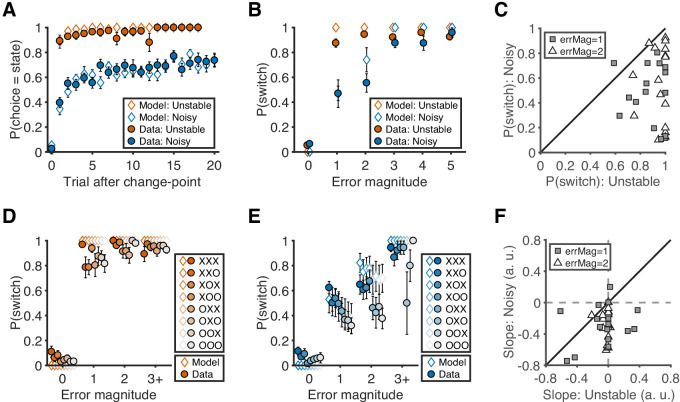
Behavioral results.(A) Probability of choosing the best target after change-points. Symbols and error bars are mean ± SEM across subjects (solid symbols) or simulations (open symbols). (B) Relationship between error magnitude and switch probability. Symbols and error bars are as in A. (C) The distribution of switch probabilities for small errors (magnitude of 1 or 2) in both conditions. Each data point represents one participant. Distributions for all error magnitudes are shown in Figure 2—figure supplement 1. (D) Probability of switch as a function of current error magnitude and error history in the unstable condition. Different colors represent different error histories for the past three trials. A correct trial is marked as O, and an error trial is marked as X. For example, XOO implies that trial t-1 was an error trial, and trial t-2 and trial t-3 were correct trials. Symbols and error bars are mean ± SEM across subjects. (E) Probability of switch as a function of current error magnitude and error history in the noisy condition. Symbols and error bars are as in D. (F) The distribution of the slopes of switch probability against error history for small errors (magnitude of 1 or 2) in both conditions. Each data point represents one participant. Distributions for all error magnitudes are shown in Figure 2—figure supplement 1.